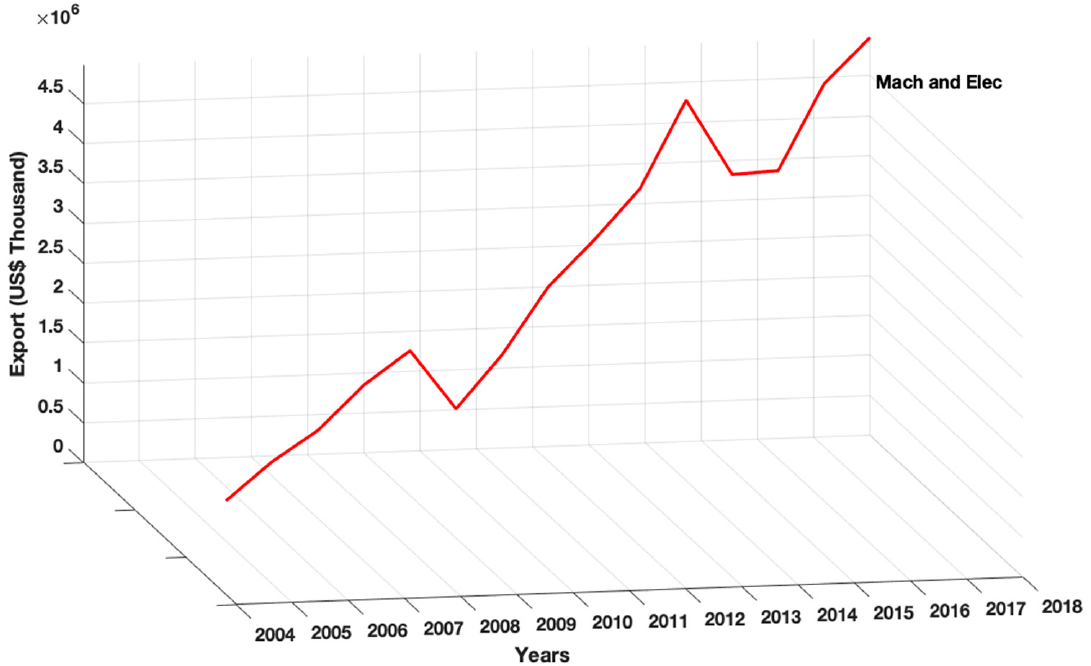
Figure 1. Development of the machinery and electrical machinery.